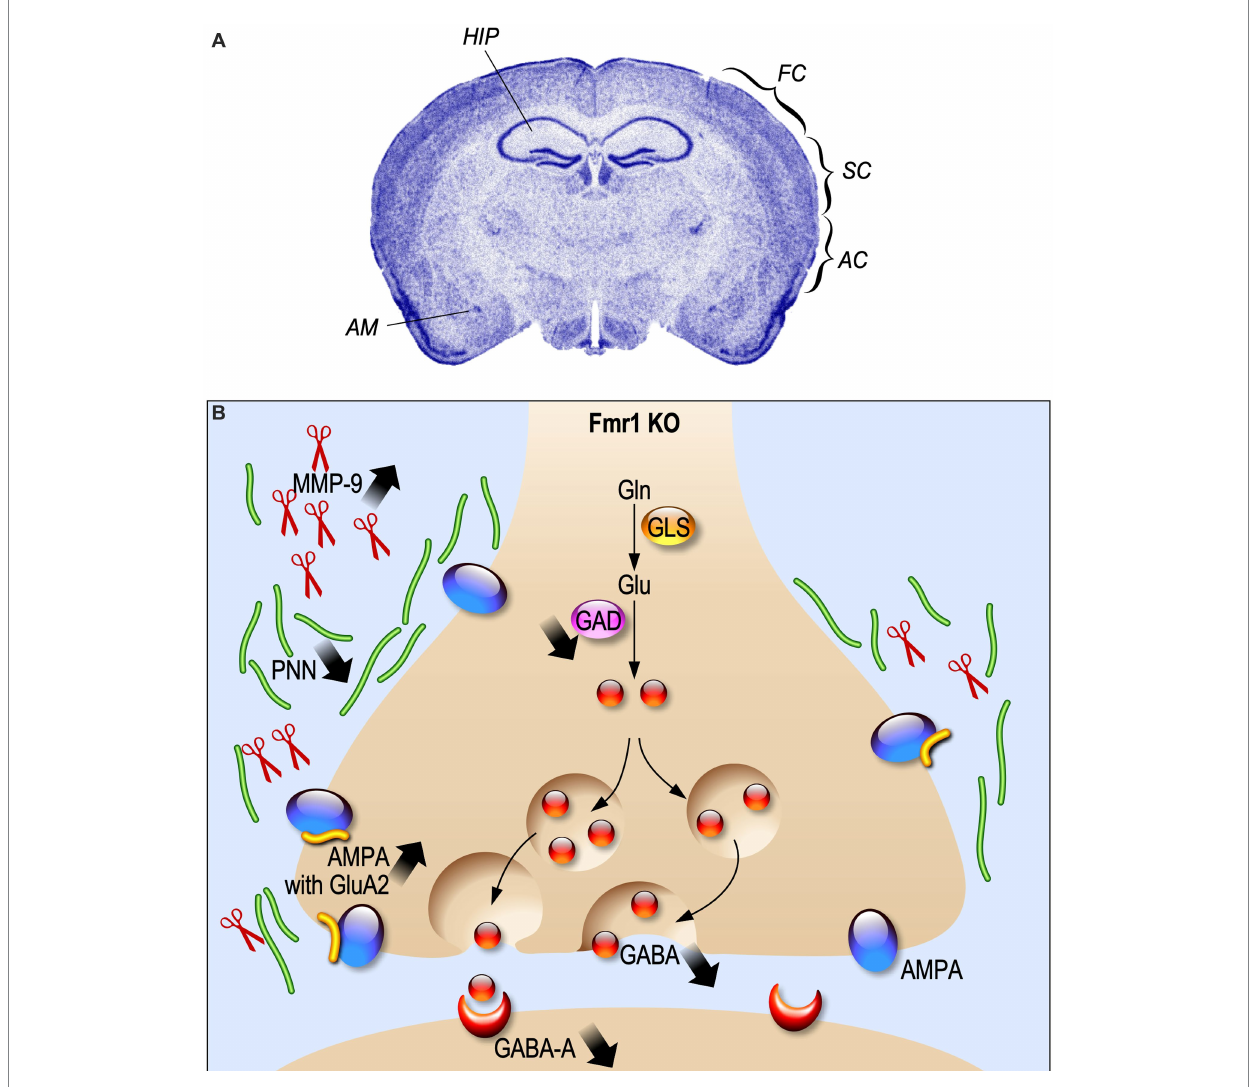
FIGURE 1 Electrophysiological alterations in Fragile X Syndrome. (A) Fmr1 KO brain regions where the inhibitory system is impaired are indicated. HIP, hippocampus; FC, frontal cortex; SC, somatosensory cortex; AC, auditory cortex; AM, amygdala. (B) Schematic representation of synaptic alteration in GABAergic